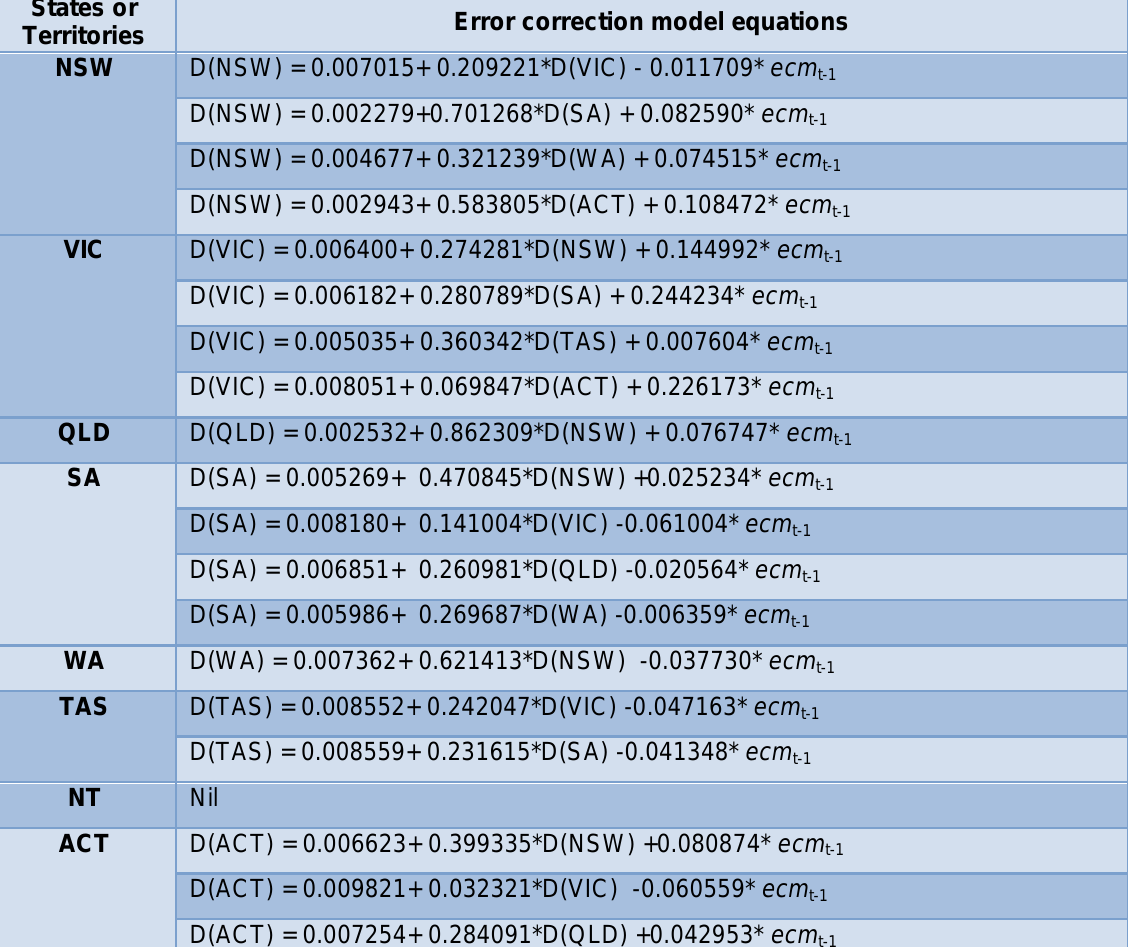
mechanism can be arbitrage and trading activities in the economic system. Table 4 presents the error correction model equations for the six states ’ and two territories ’ producer price index series of house construction based on Engle-Granger co-integration test results. D(.) denotes the data series of the item included in the bracket at the first difference level. The coefficient of the D(.) on the right of the equation denotes the short term elasticity of changing, which is the short term changing rate. The coefficient of ecm of adjustment from short term disequilibrium back to a long term equilibrium relationship.